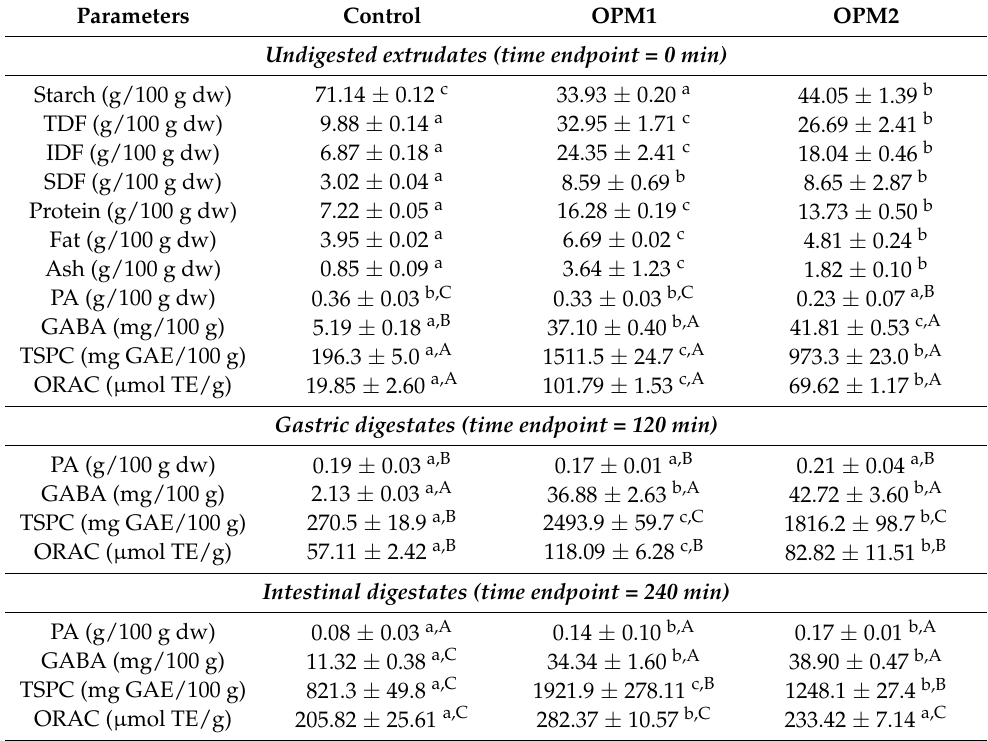
Table 6. Nutritional composition of corn (control) and optimized extrudates elaborated with